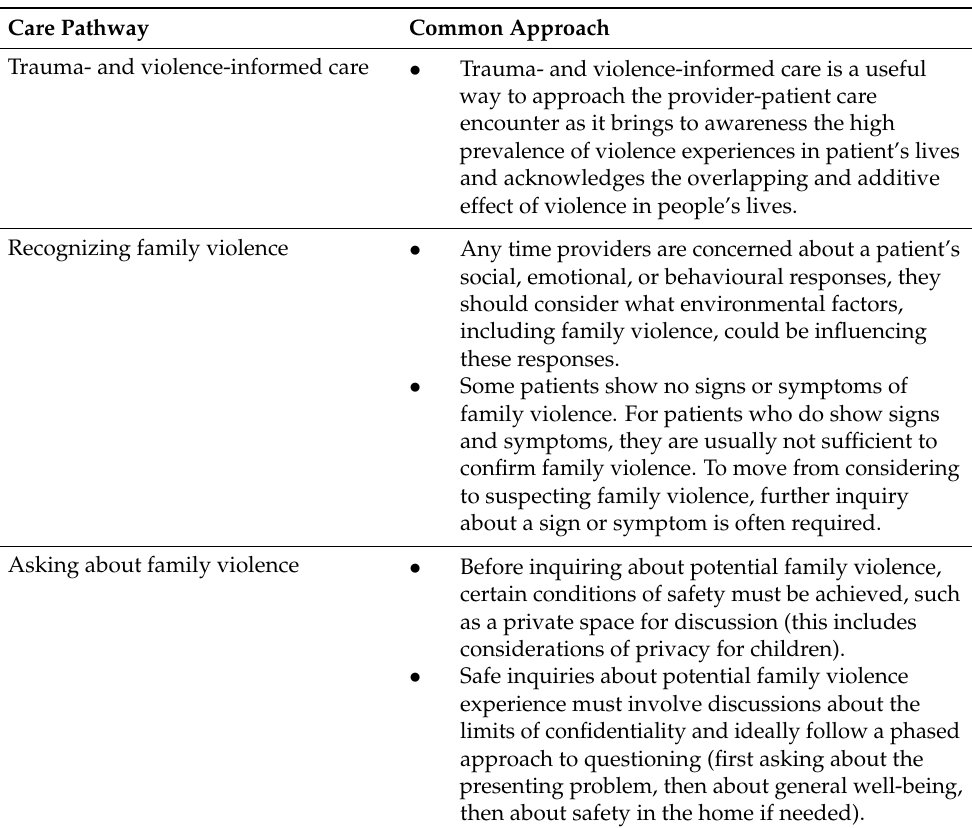
Table 1. VEGA principles for a common approach to recognizing and safely responding to family violence